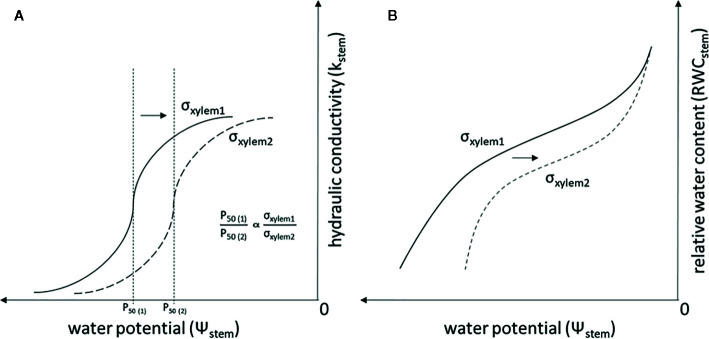
Theoretical relationship of σxylem, Kstem and Ψstem
(A), and the theoretical relationship of σxylem, RWCstem and Ψstem
(B) when σxylem is changed. Symbols refer to surface tensions of pure water (σxylem1) and xylem sap with lowered surface tension (σxylem2), P50 (1) is the P50 value (i.e. the Ψstem where 50% of the conductivity in water transport is lost because of embolism) when the xylem sap surface tension corresponds to σxylem1, and P50 (2) is the P50 value when the xylem sap surface tension corresponds to σxylem2. The relationship between P50 and σxylem is linear and is demonstrated also for conifers in Cochard et al. (2009).